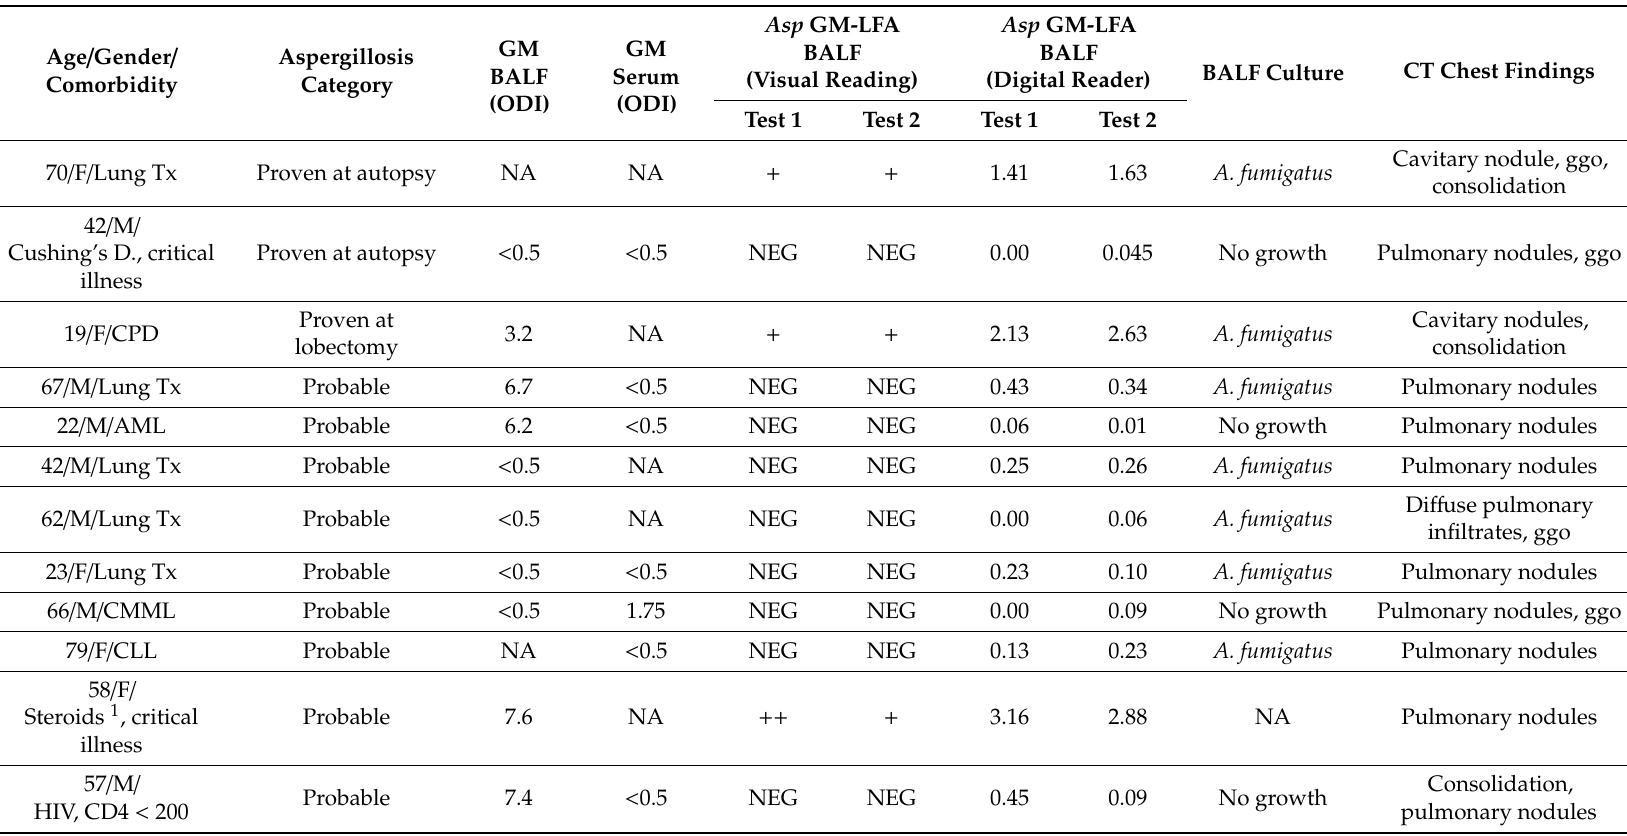
Table 2. Demographics, underlying diseases, radiographic findings, and test results for 20 patients who underwent bronchoscopy and bronchoalveolar lavage and who were diagnosed with invasive pulmonary